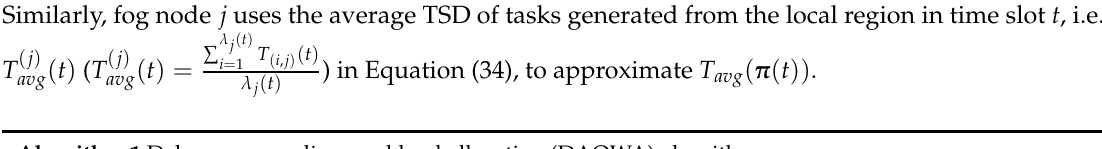
Algorithm 1 Delay-aware online workload allocation (DAOWA)